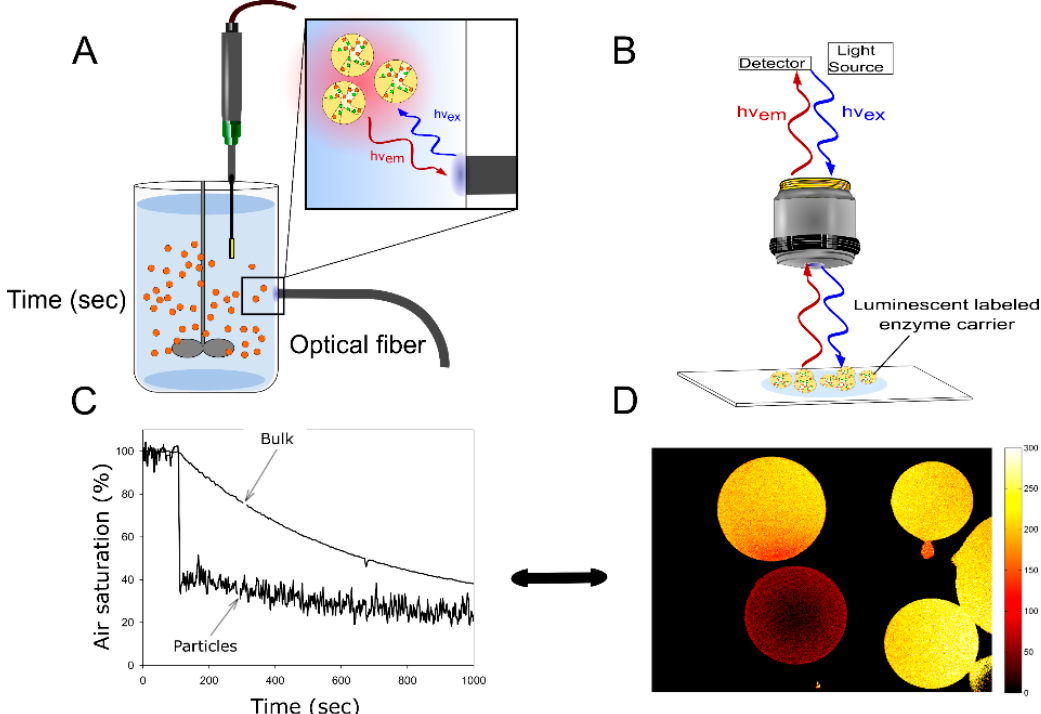
Figure 5. Read-out strategy and spatiotemporal resolution provided by opto-chemical sensing in enzyme immobilizates. ( A ) Interfacing fiber optics with oxygen sensitive particles for space-averaged determination of intraparticle analyte concentrations. ( B ) Interfacing opto-chemical sensing with a microscopy set-up for the spatial resolution of intraparticle concentrations in stagnant solutions or in a fixed bed. ( C ) Time courses of the average intraparticle oxygen concentration and the corresponding oxygen concentration in bulk when O 2 is utilized as substrate by an immobilized enzyme. ( D ) Example ofthespatialresolutionofintraparticleoxygenconcentration. Thefigurewasadaptedfromreference[14] with permission from